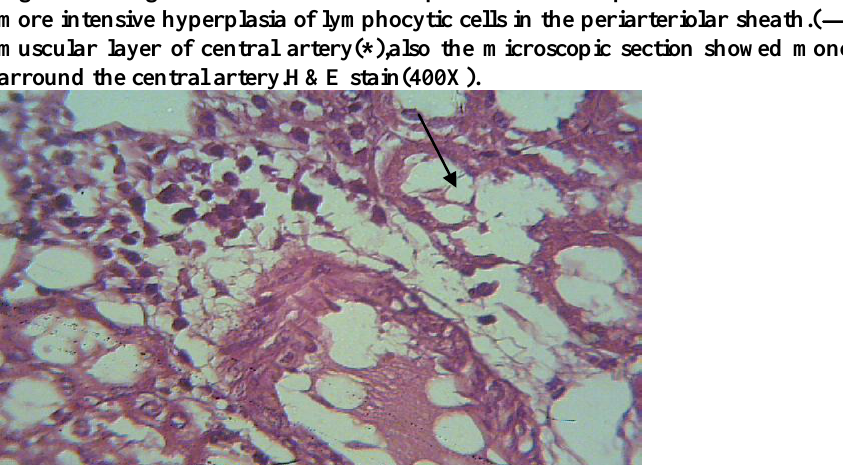
Fig 3: Histological section of the mice kidney at 2 weeks post immunization with HK-CA+FCA showed mononuclear cells aggregation arround blood vessel and between renal tubules(